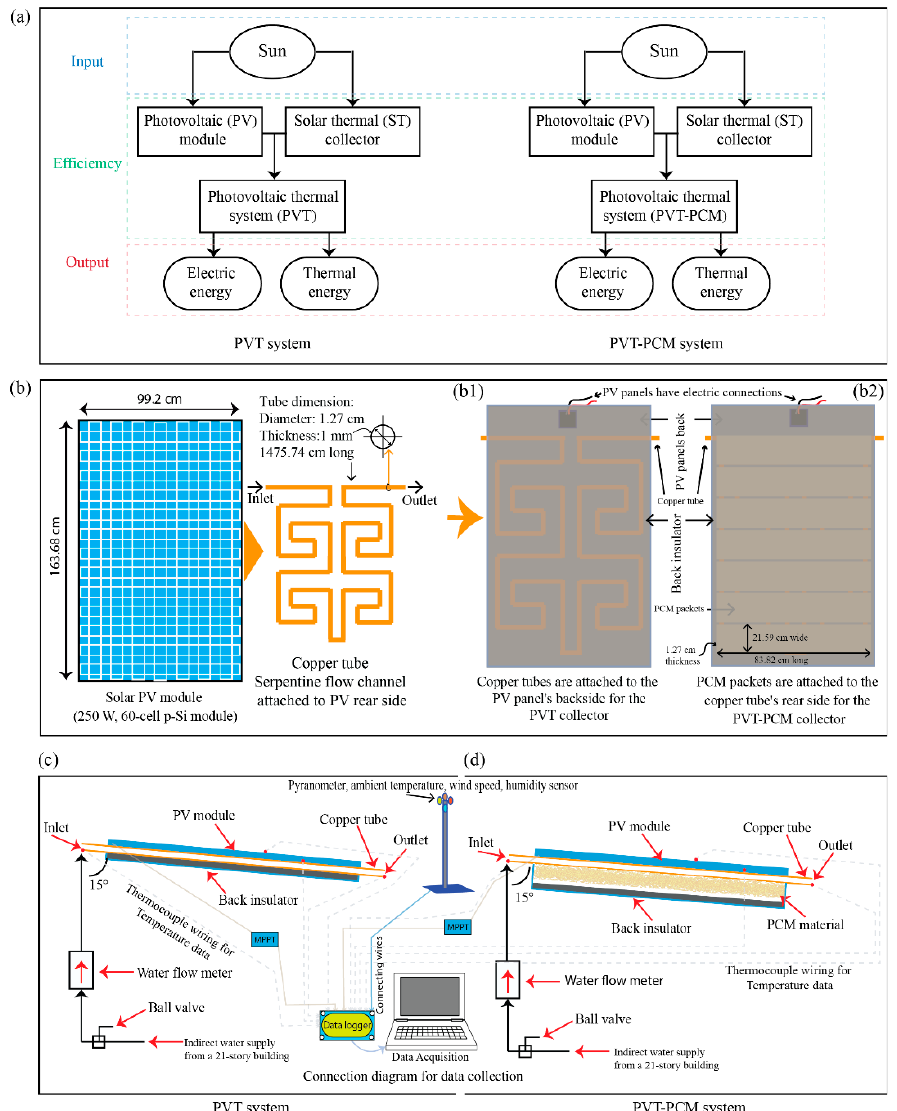
Figure 1. ( a ) Working principle of PVT and PVT-PCM systems; ( b ) PV module, double serpentine flow channel attached to PV rear side; ( b1 ) PVT and ( b2 ) PVT-PCM thermal collectors; ( c , d ) PVT and PVT-PCM experimental setups for onsite comparative performance study.